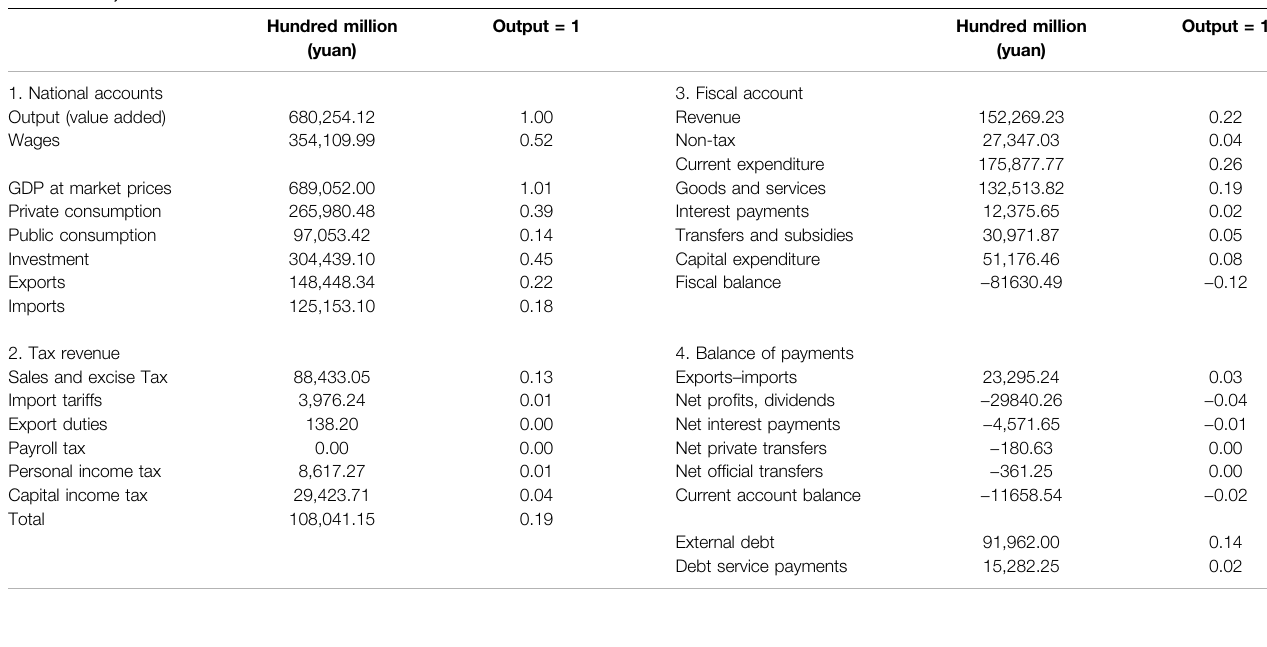
TABLE 2 | Dataset of the “ 1-2-3 ” model.